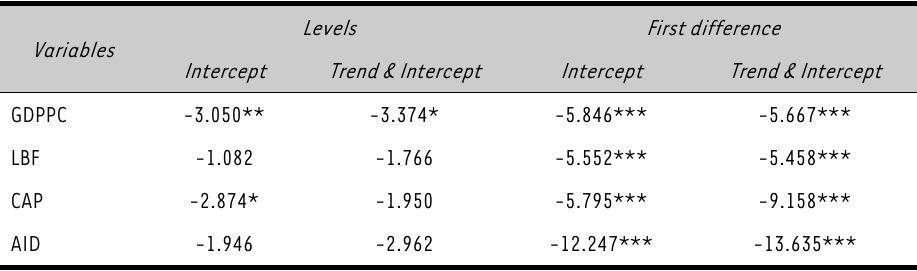
Summary of unit root tests: